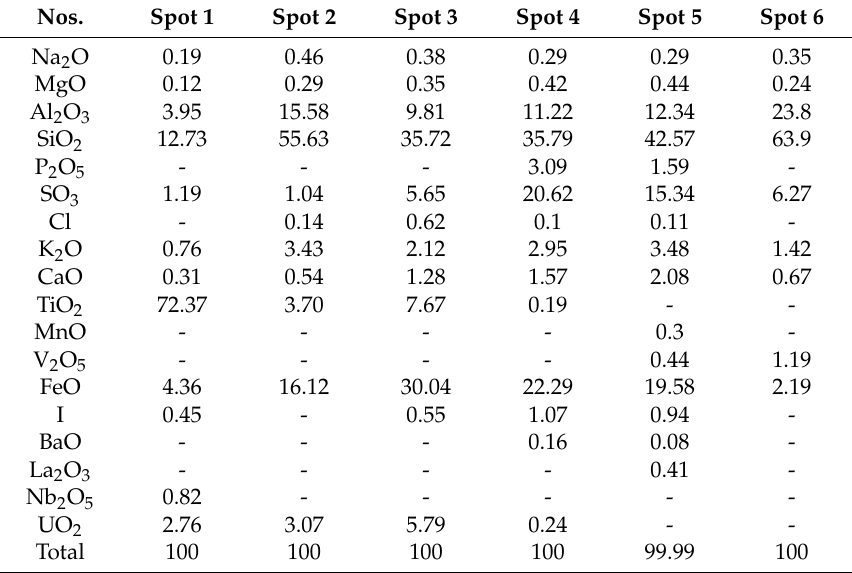
Table 3. EMPA results for the minerals in Figure 5 (%).